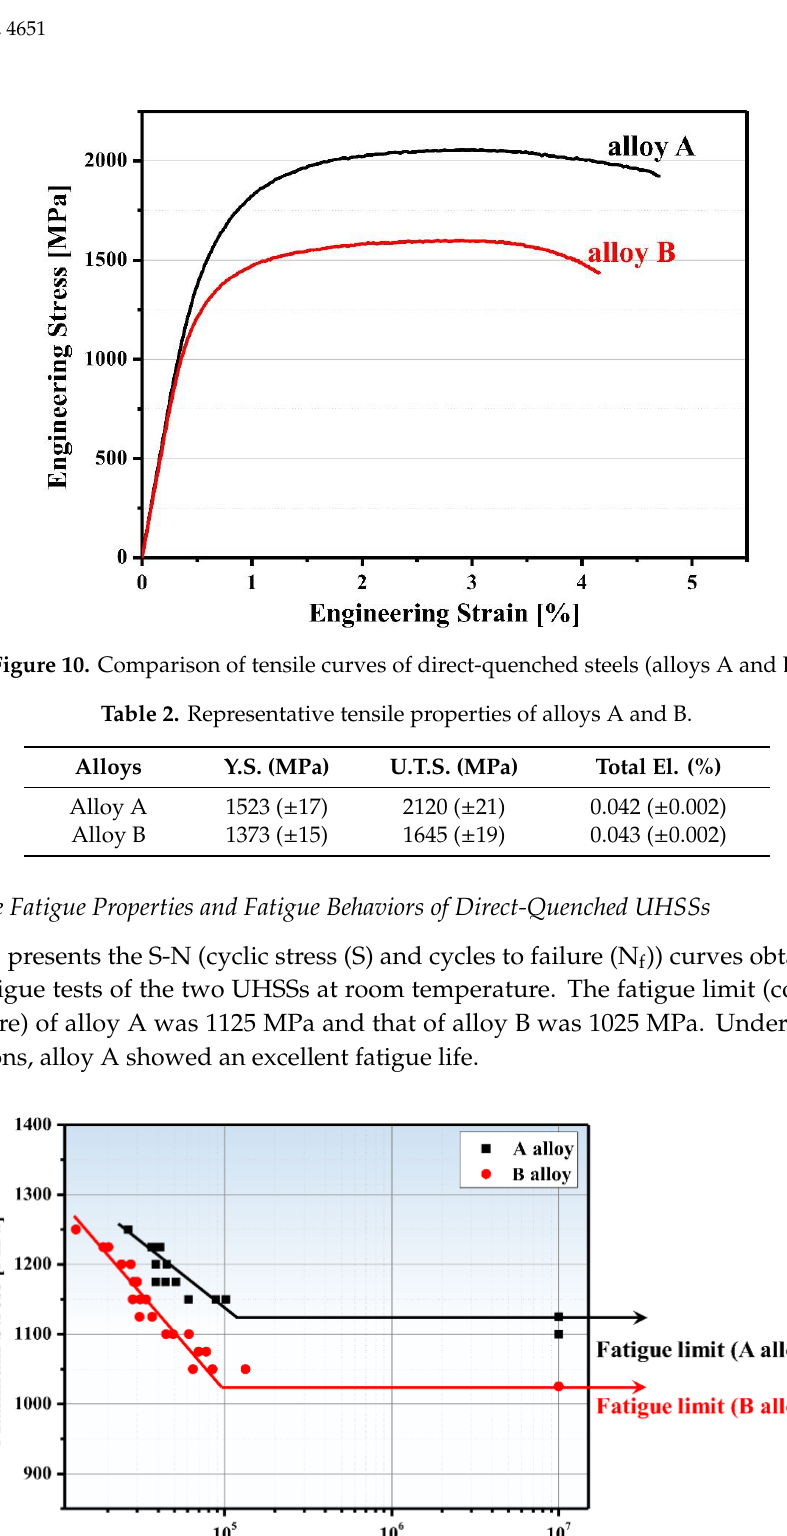
Figure 11. Comparison of high-cycle fatigue properties (S–N curves) of alloys A and B.